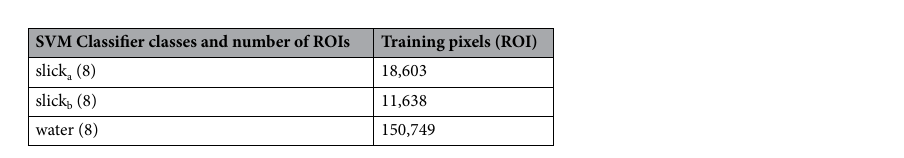
Table 3. Training and testing samples for SVM classification.